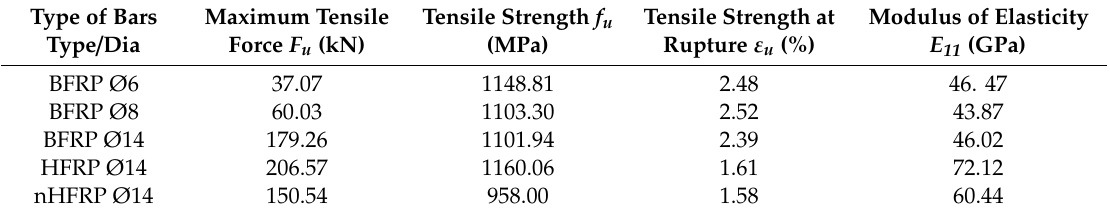
Table 3. Mechanical properties of the fiber-reinforced polymer (FRP) bars utilized in the tests. Type of Bars Type /